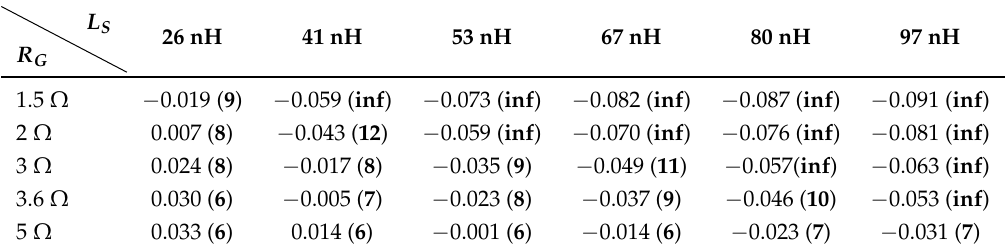
Table 3. A comparison between the ζ 1 and number of oscillation cycles N C ( bold ) with various R G and L S with L C = 410